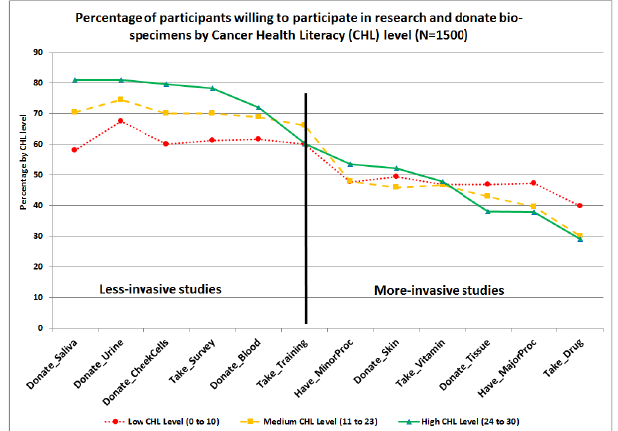
Figure 6. Item-level differences on willingness to participate in research and donate bio-specimens scale by cancer health literacy level.